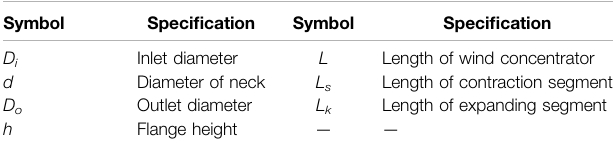
TABLE 1 | The key geometric parameters.